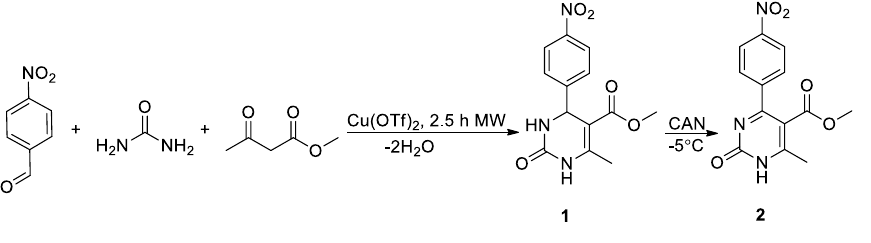
Figure 2. Synthesis of compounds 1 and 2